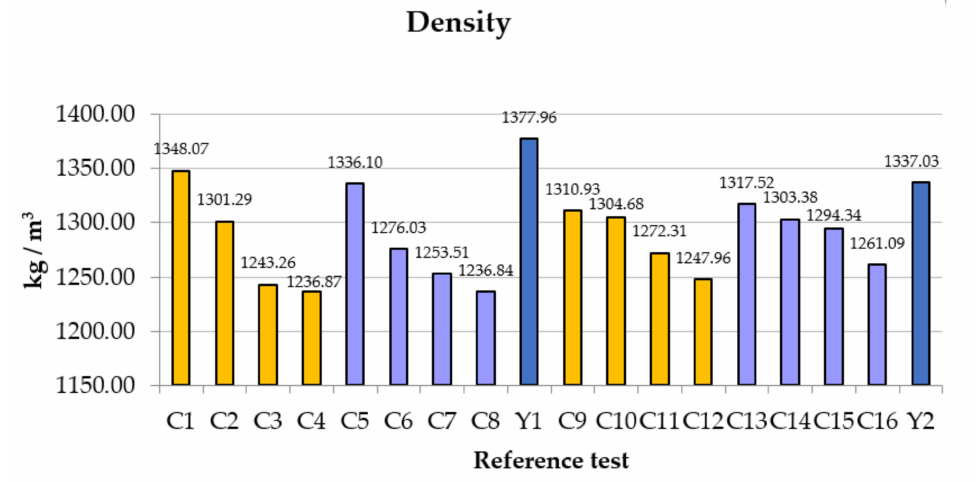
Figure 6. Comparative results of